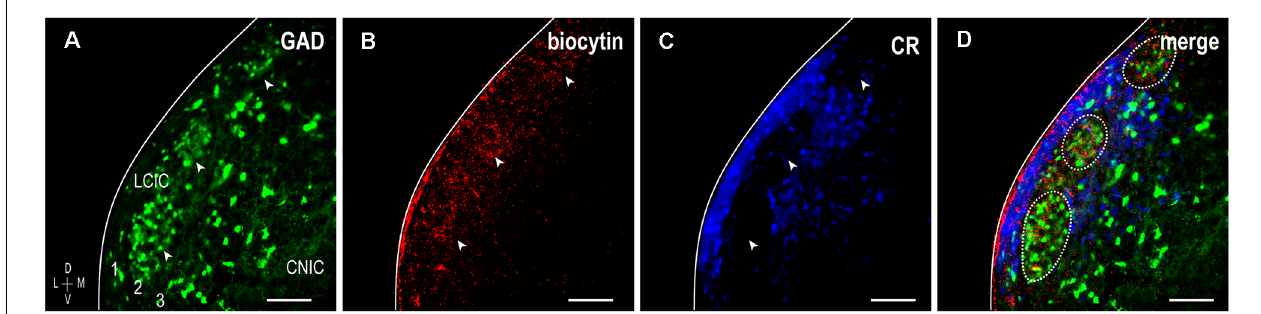
FIGURE 4 | Somatosensory corticocollicular projections specifically target GAD modules by P12, and are complementary to the CR-positive matrix. GAD-positive modules are easily discerned at this age ( A , arrowheads) and align with patchy somatosensory terminal fields ( B , arrowheads), as well as layer 2 modular voids evident in CR staining of the matrix ( C , arrowheads). A digital merge (D) of the separated channels provides definitive evidence of highly refined projection patterns reminiscent of those previously described in adult mouse (see Lesicko et al., 2016). Scale bars = 100 µ m.